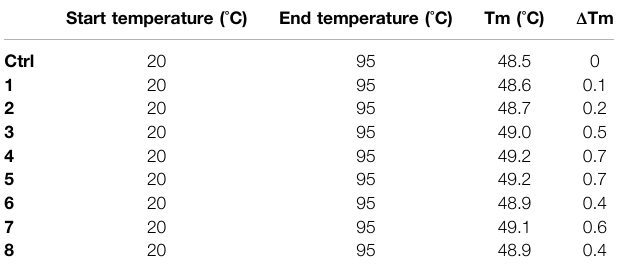
TABLE2| NanoDSFassayswereperformedusingthePrometheus.Thepeptides screening was performed at the fi xed dose of 200 μ M, with a protein concentration of 40 µM. For the analysis, standard capillaries were used.